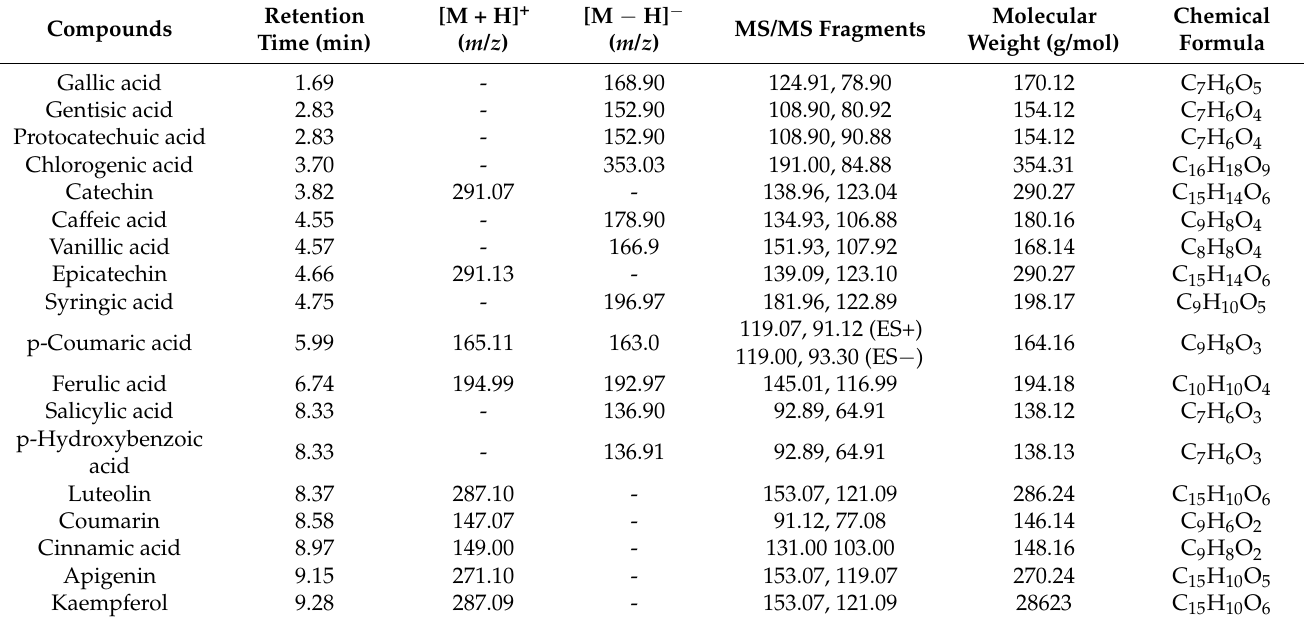
Table 1. Mass spectrometric parameters of nine phenolic compounds.